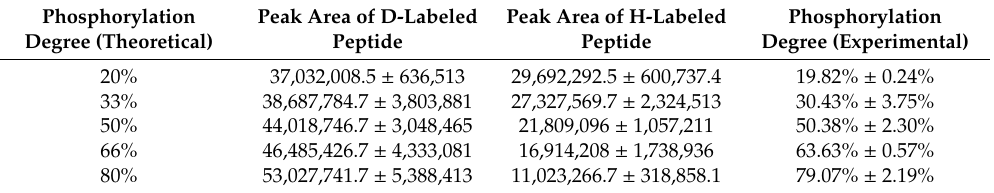
Table 1. The phosphorylation degree (PD%) was determined using the following equation: PD (%) = (( I’ NPP-D − I NPP-H ) / I’ NPP-D ) × 100%. The linearity assay of the DM + deP approach was demonstrated by the simulated phosphorylation degree using synthetic TR-16 and